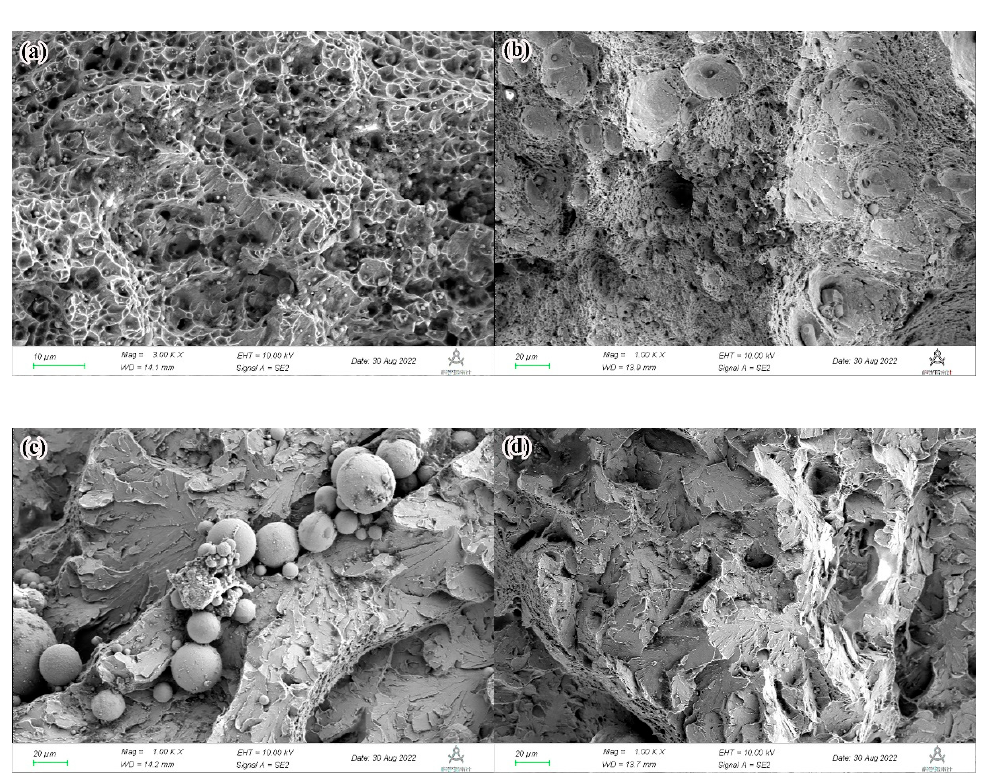
Figure 12. Fracture morphology of low-temperature impact: ( a ) G20Mn5QT; ( b ) No. 5; ( c ) No. 8; ( d ) No. 9.